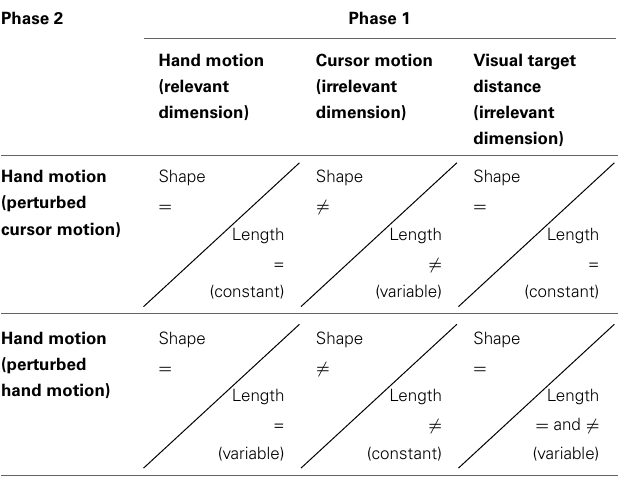
Table 1 | The experimental variations of the dimensions shape and length, and their dimensional overlap in phases 1 and 2 (“ = ”, similar; i.e., dimension does overlap; “ (cid:2)= ”, dissimilar; i.e., dimension does not